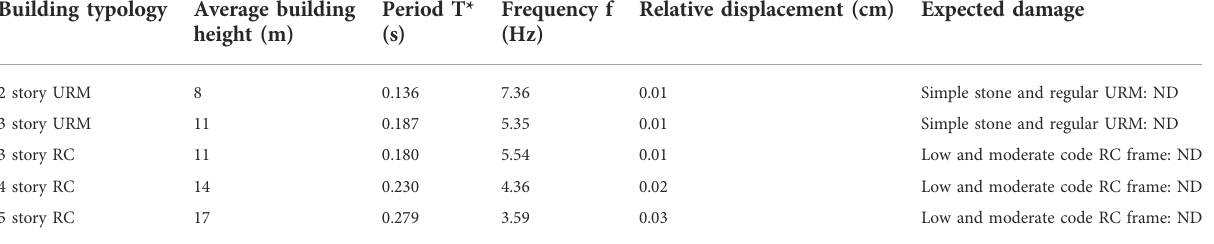
TABLE 5 Damage assessment for different building typologies for Sulmona (2-3 story URM and 3-5 story RC